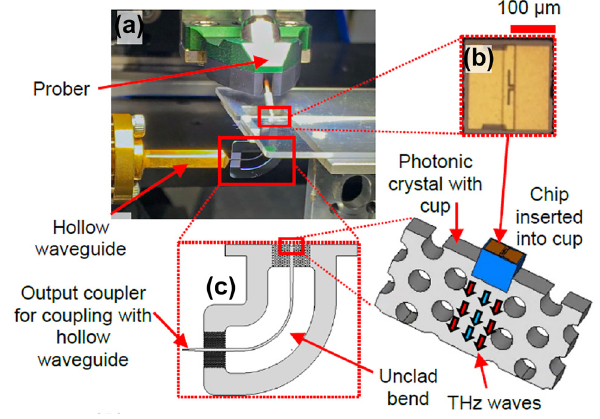
Figure 9: Backside coupled RTD hybrid integration with photonic crystal platform, (a) experimental setup for characterization showingunclad waveguide bend as inset, (b) slot antenna RTD chip.